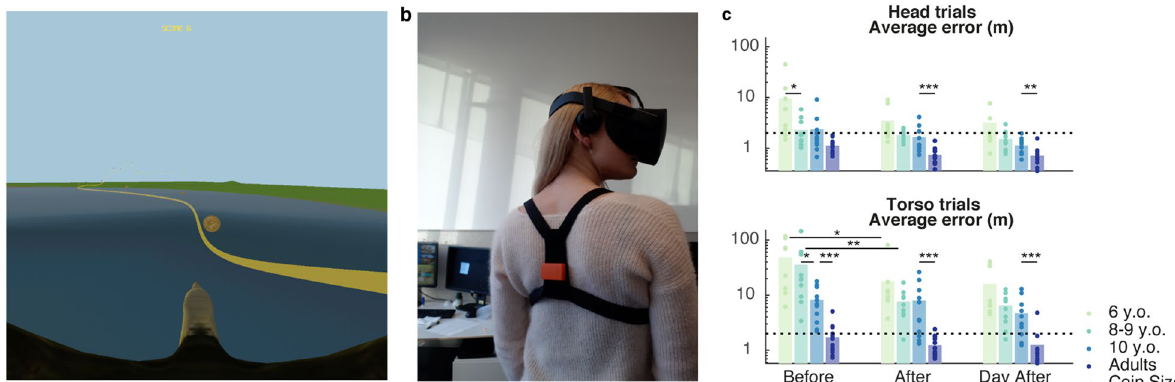
Figure 1. Experimental setup and task performance. ( a ) Virtual environment, as seen by the participant, representing the coins to catch and an underlining ideal trajectory depicted by the yellow line. ( b ) Experimental apparatus worn by the participants, consisting of an HMD and an IMU held in place in the back by a harness. ( c ) Performance on the navigation task, computed as the average distance to the coin centre (error). Dots represent the average error for each individual participant, bars the average across participants. N = 9 (6 y.o.), 12 (8–9 y.o.), 11 (10 y.o.), 13 (adults). Significance levels: p < 0.001 (***), p < 0.01 (**), p < 0.05